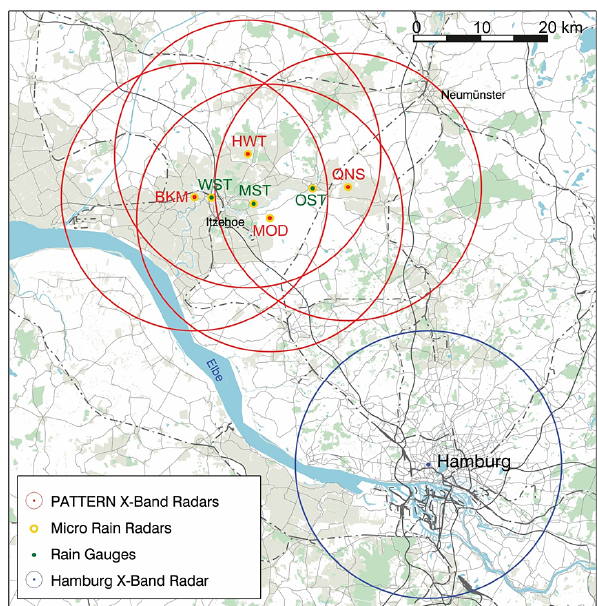
Figure 1. Position of the four network radars: Hungriger Wolf tower (HWT), Quarnstedt (QNS), Bekmünde (BKM) and Moordorf (MOD) marked in red, the Hamburg radar marked in blue, and their 20km range. Reference stations OST, MST and WST are marked in green.